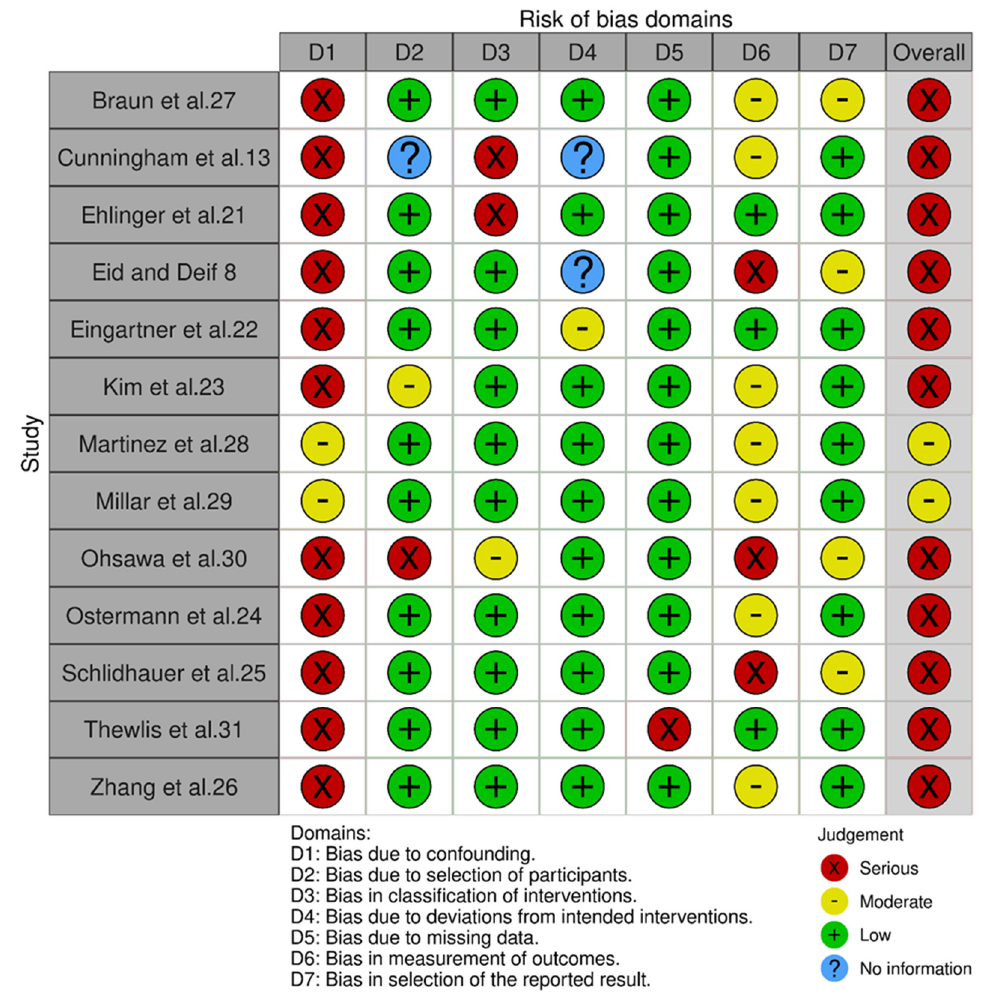
Figure 3. Non-randomized controlled trials risk of